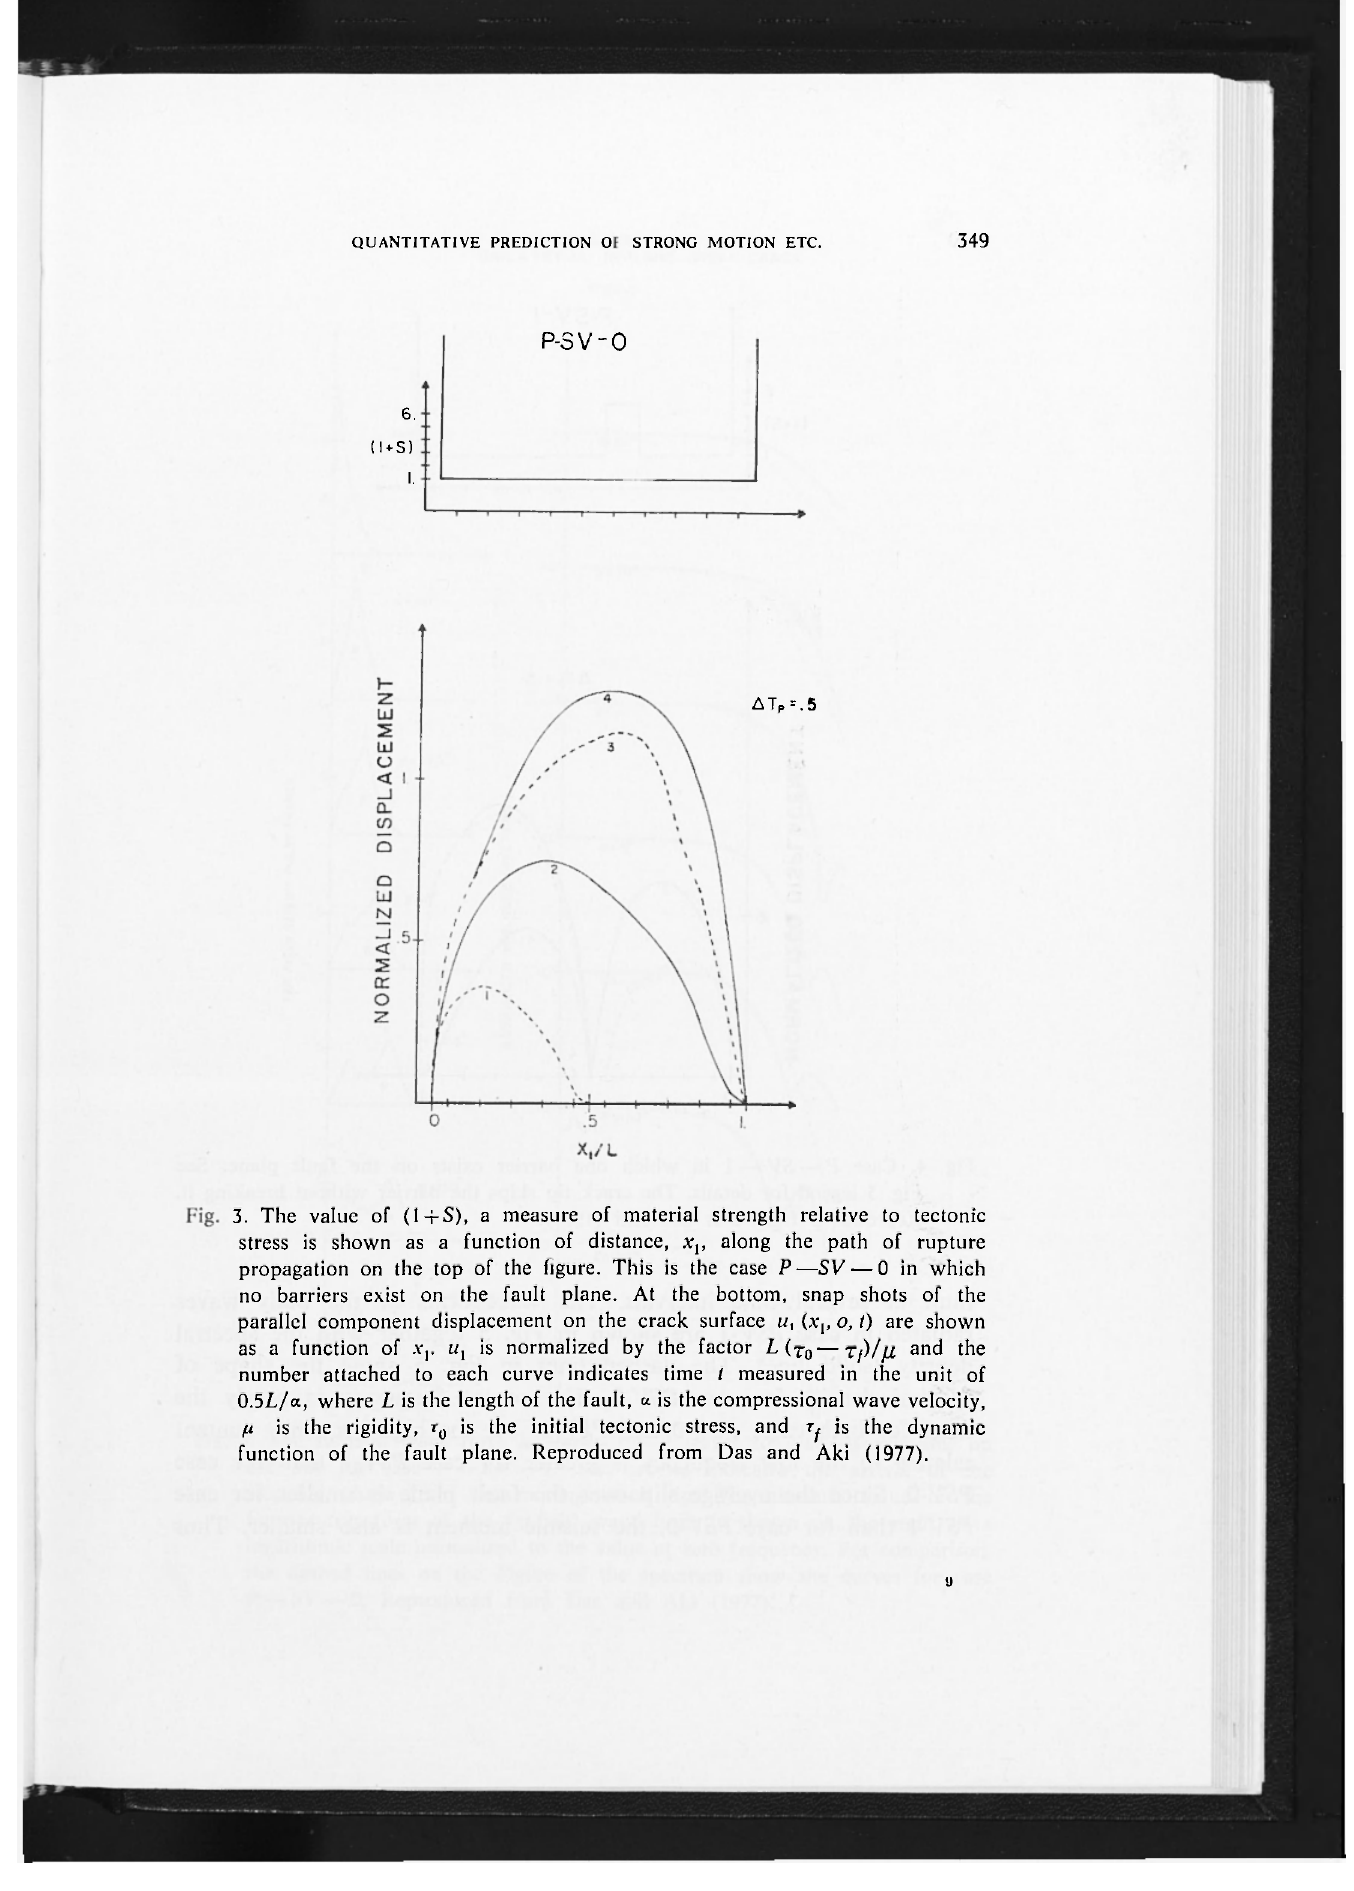
3. The value of (1+S), a measure of material strength relative to tectonic stress is shown as a function of distance, x lt along the path of rupture propagation on the top of the figure. This is the case P — SV — 0 in which no barriers exist on the fault plane. At the bottom, snap shots of the parallel component displacement on the crack surface (x p o, 1) are shown as a function of .*,. u, is normalized by the factor L(x o— zj)/[i and the number attached to each curve indicates time t measured in the unit of 0.5 L /a., where L is the length of the fault, a is the compressional wave velocity, H is the rigidity, r 0 is the initial tectonic stress, and jy is the dynamic function of the fault plane. Reproduced from Das and Aki